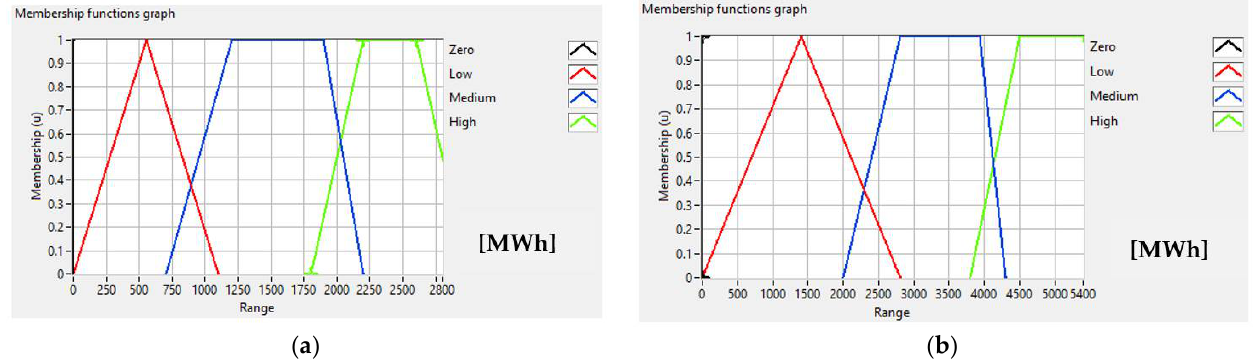
Figure 9. Membership functions of the output variables of hydroelectric power plants obtained from the defuzzification process. ( a ) Minimum energy to be generated; ( b ) maximum energy to be generated. X-axis range in (MWh).